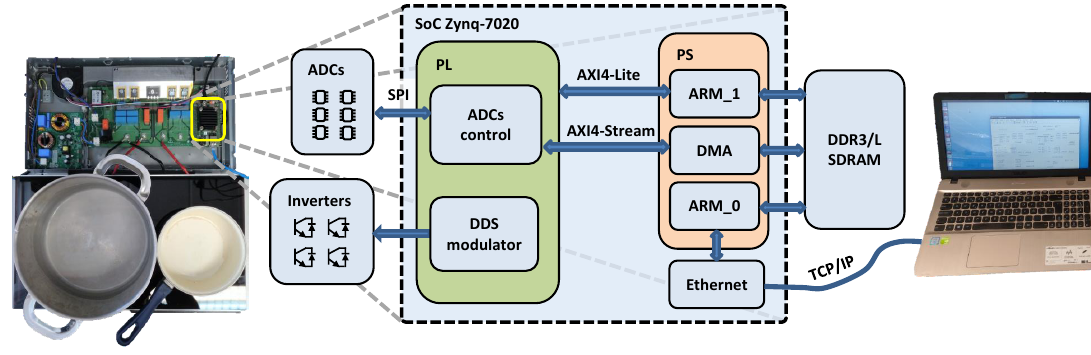
Figure 7. Experimental setup of the